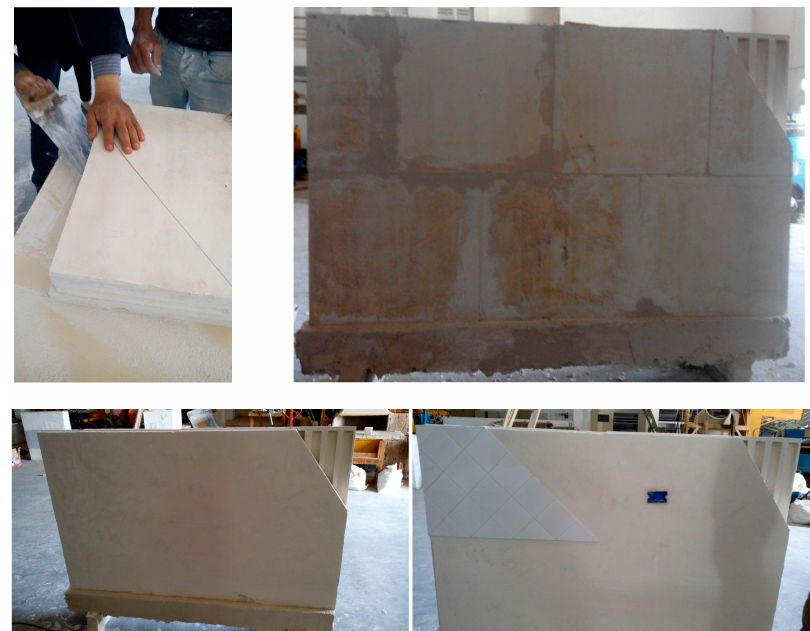
Figure 18. Steps of wall prototype construction.